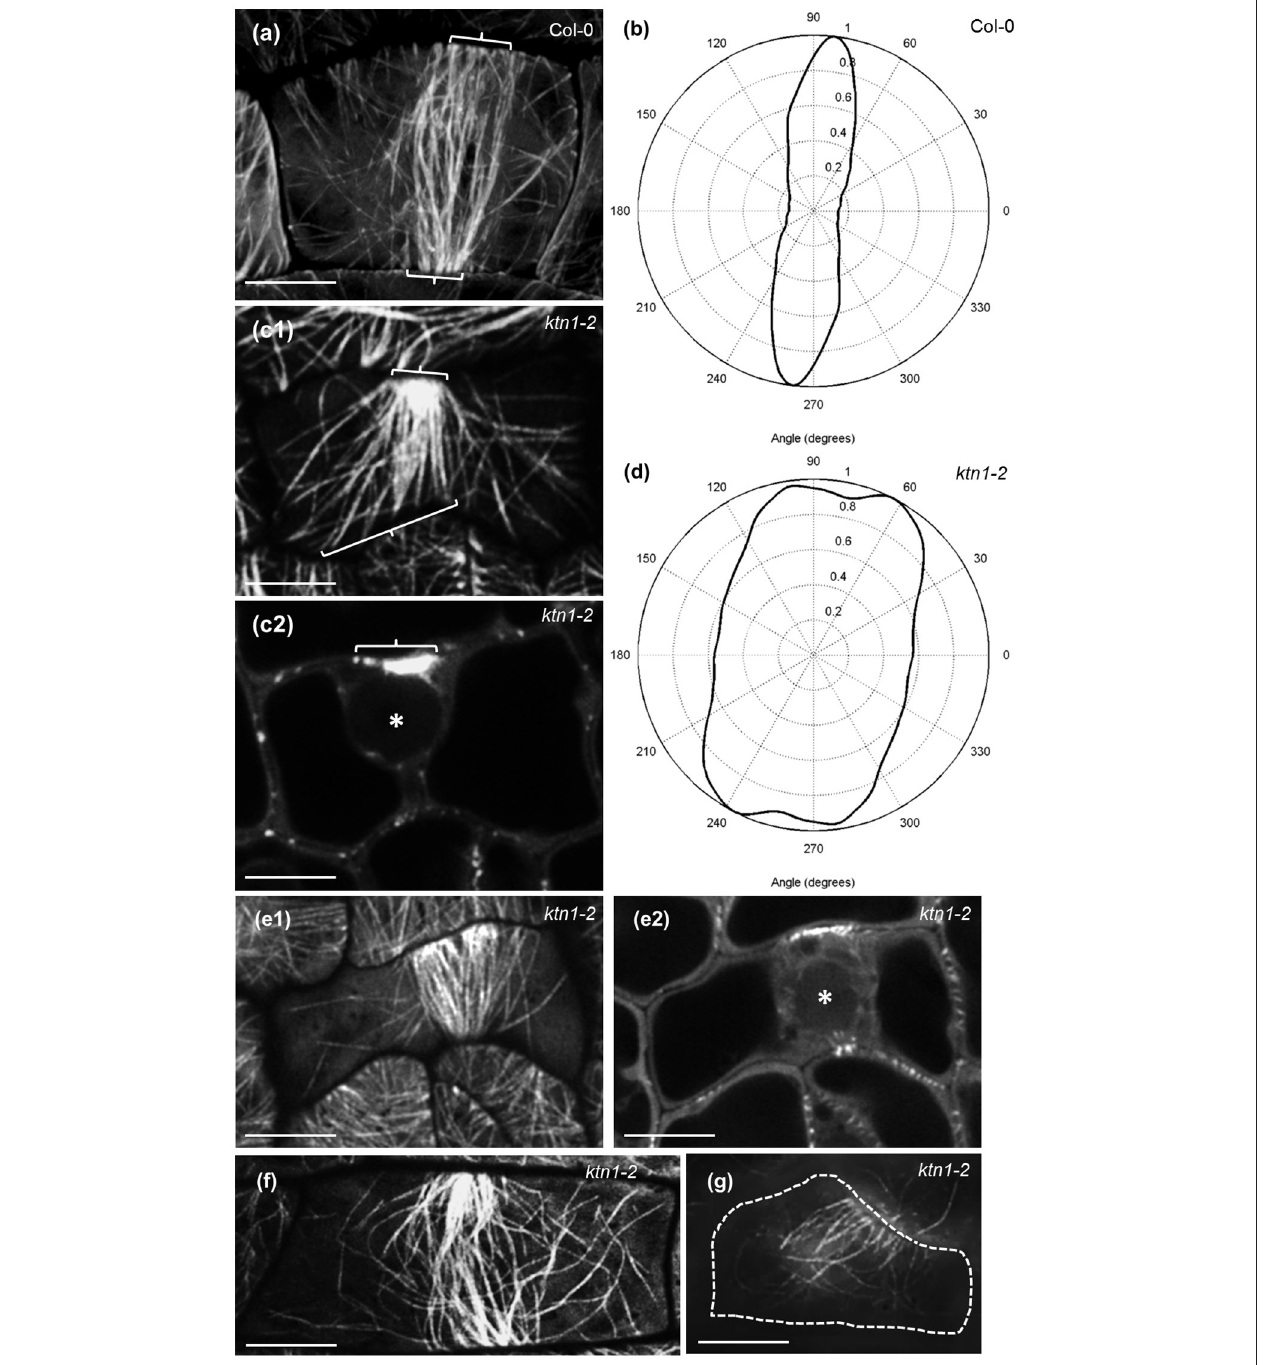
FIGURE 5 | PPB organization and MT anisotropy in Col-0 and ktn1-2 mutants expressing a GFP-TUA6 microtubule marker. Single optical sections were acquired with Airyscan CLSM (a,c,e,f) and SIM (g). (a) Typical early PPB (brackets) of Col-0 dividing petiole epidermal cell showing roughly parallel and homogeneous distribution of microtubules. (b) Angular distribution of microtubules in PPB of (a) showing a rather uniform transverse orientation. (c1,c2) Early PPB of ktn1-2 petiole epidermal cell at surface (c1) and mid (c2) planes, showing a well-focused side and a much broader microtubule distribution on opposite side ( c1,c2 brackets) with long microtubules emanating from the PPB to the rest of the cortex. Scanning time was 4.28min for the entire Z-stack while a rotating panoramic view can be found in Video S1 . (d) Angular distribution of microtubules in PPB of (c1) showing much broader orientation than in (a) although with a transverse orientation trend. (e–g) More examples of abnormal PPB organization in ktn1-2 including a fan-shaped PPB at surface (e1) and at middle ( e2; asterisk denotes position of nucleus optical planes), a broad, disordered (f) and an incomplete one (g) . Asterisk in (c2) and (e2) indicates position of nucleus. Scanning time was 3.74min for (e1,e2) and 17.8s for (f) ; (g) is a single optical section Scale bars: 5 µ